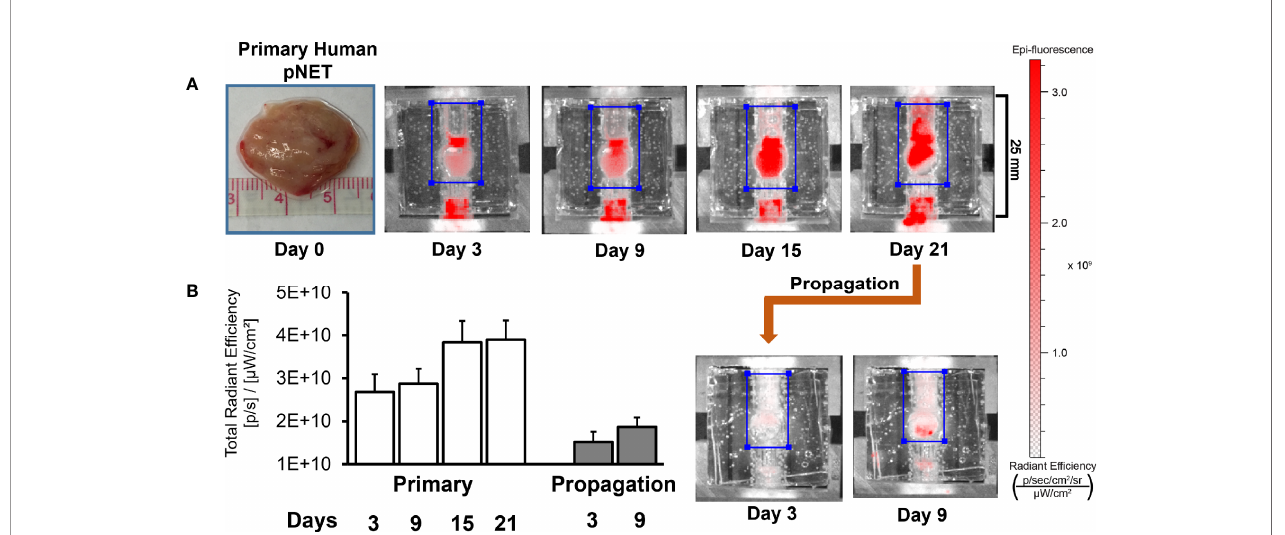
FIGURE 10 | Human NET surrogates can be propagated in the bioreactor for long-term growth. (A) A human pNET was implanted into the bioreactor system and propagated successfully after 21 days of growth. The surrogate was terminated and fi xed 9 days after propagation. (B) Quantitation of radiant ef fi ciency data during the culture